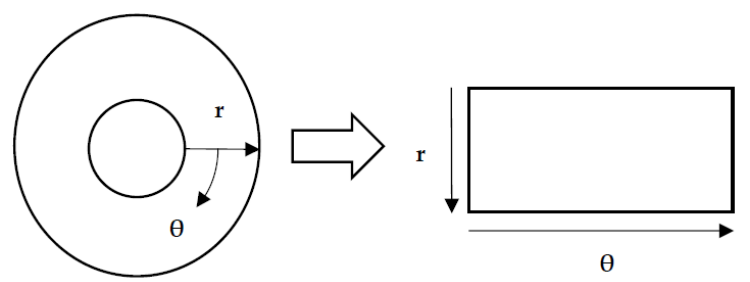
Figure 5. Iris normalization.